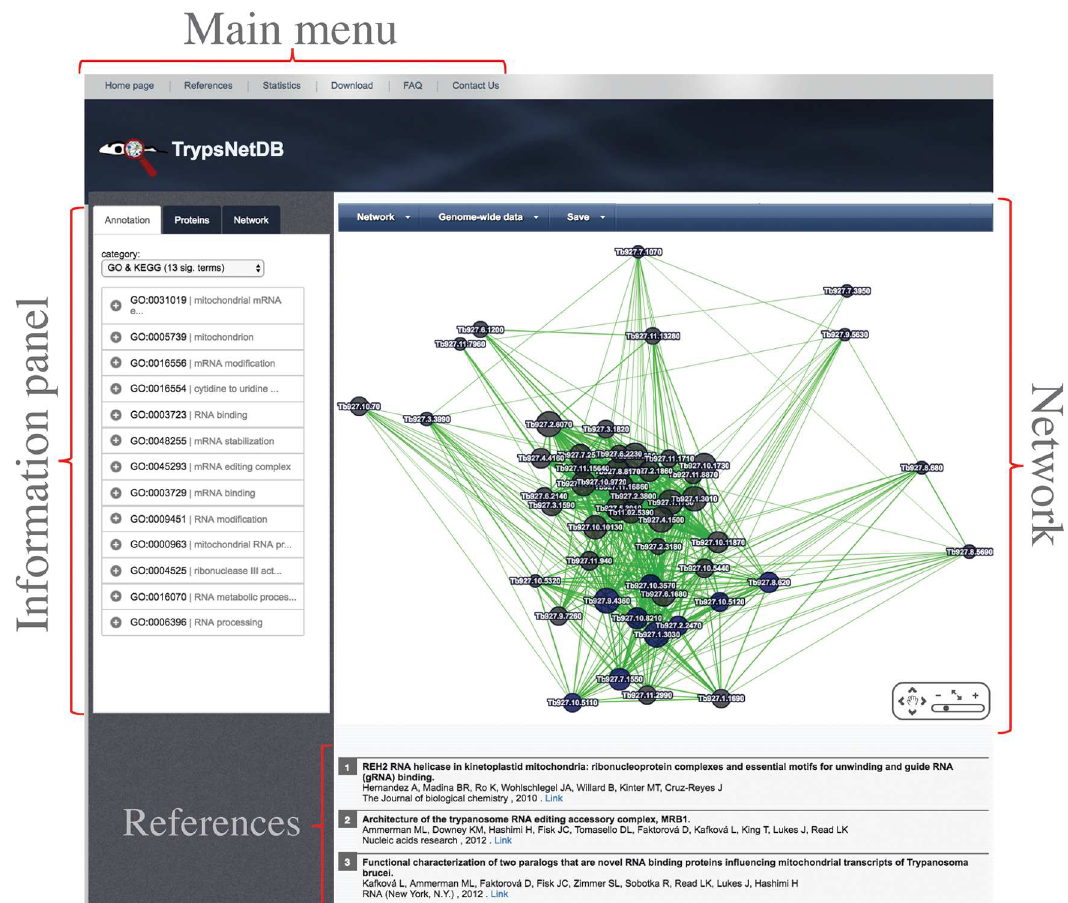
Fig 2. The main result page of TrypsNetDB. The main result page is composed of three elements; that is, information panel, network section, and referencessection. The information panel containsenrichment analysisresults, brief characteristics of the proteins, and the interactiontypes present in the illustratednetwork. The network section can be used to explorethe interactionsamong the proteins. Using the menu on the top of the interaction section, users can change the visualization style of the network, access the dynamic heatmapsfrom various genome-wide data, and save the results. The reference section includesstudies from which the interaction data of the illustrated network were extracted with the direct PubMed